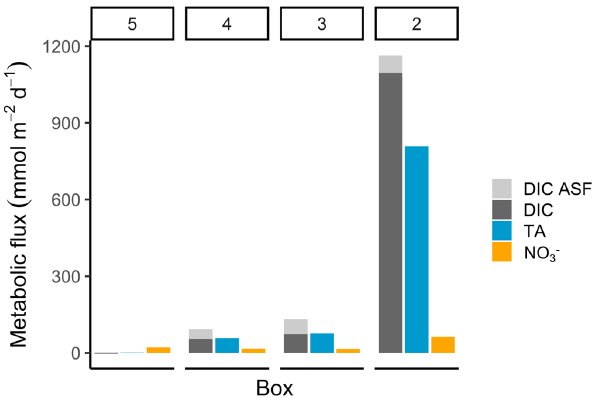
Figure 5. Metabolic fluxes of total alkalinity, dissolved inorganic carbon, and nitrate. The metabolic fluxes of TA (blue), DIC (dark grey), and NO − (orange; in mmolm − 2 d − 1 ) are shown, with the ad- 3 ditional visualization of the air–sea flux (ASF) contribution to DIC (light grey) to demonstrate the entire generation and their relative